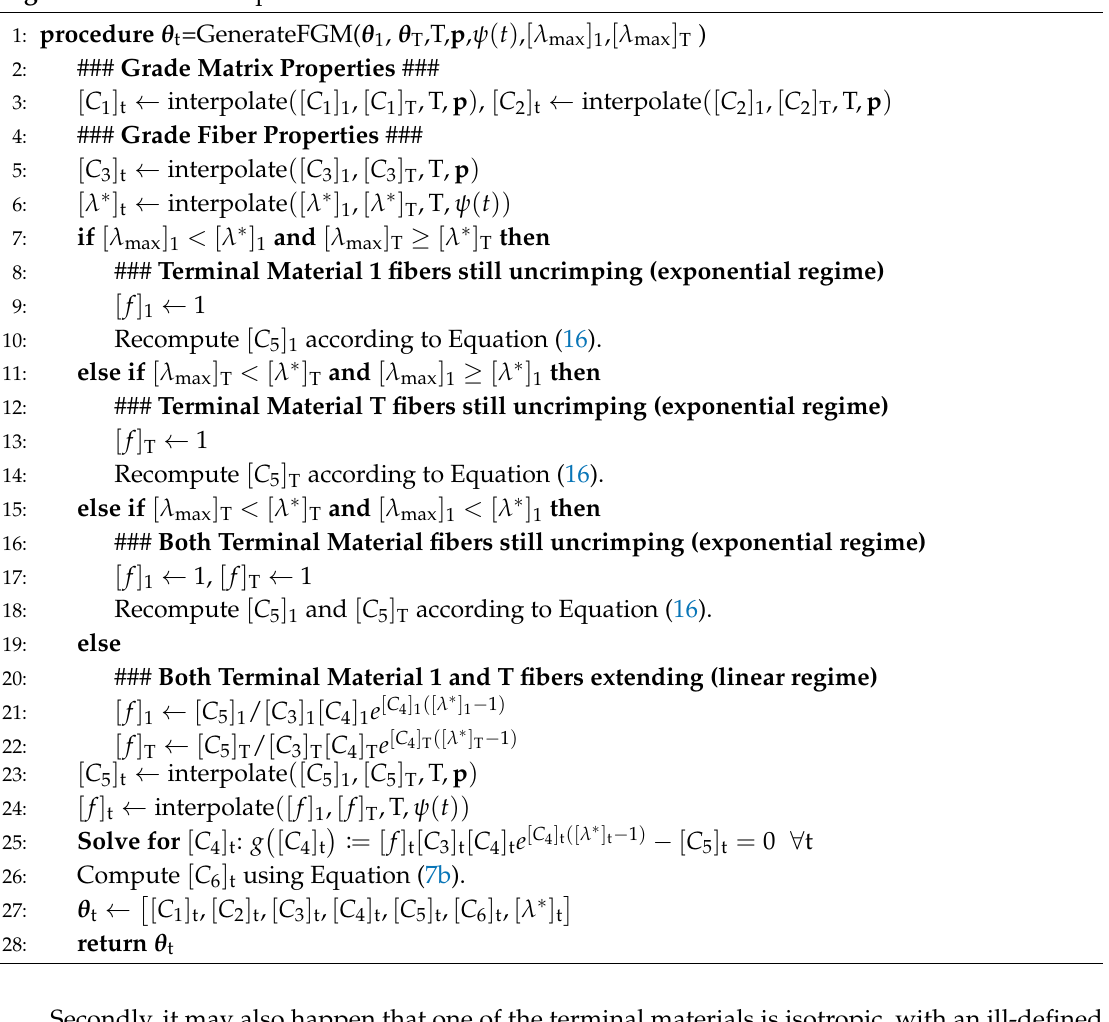
Algorithm 1 FGM Interpolation Law for the TI